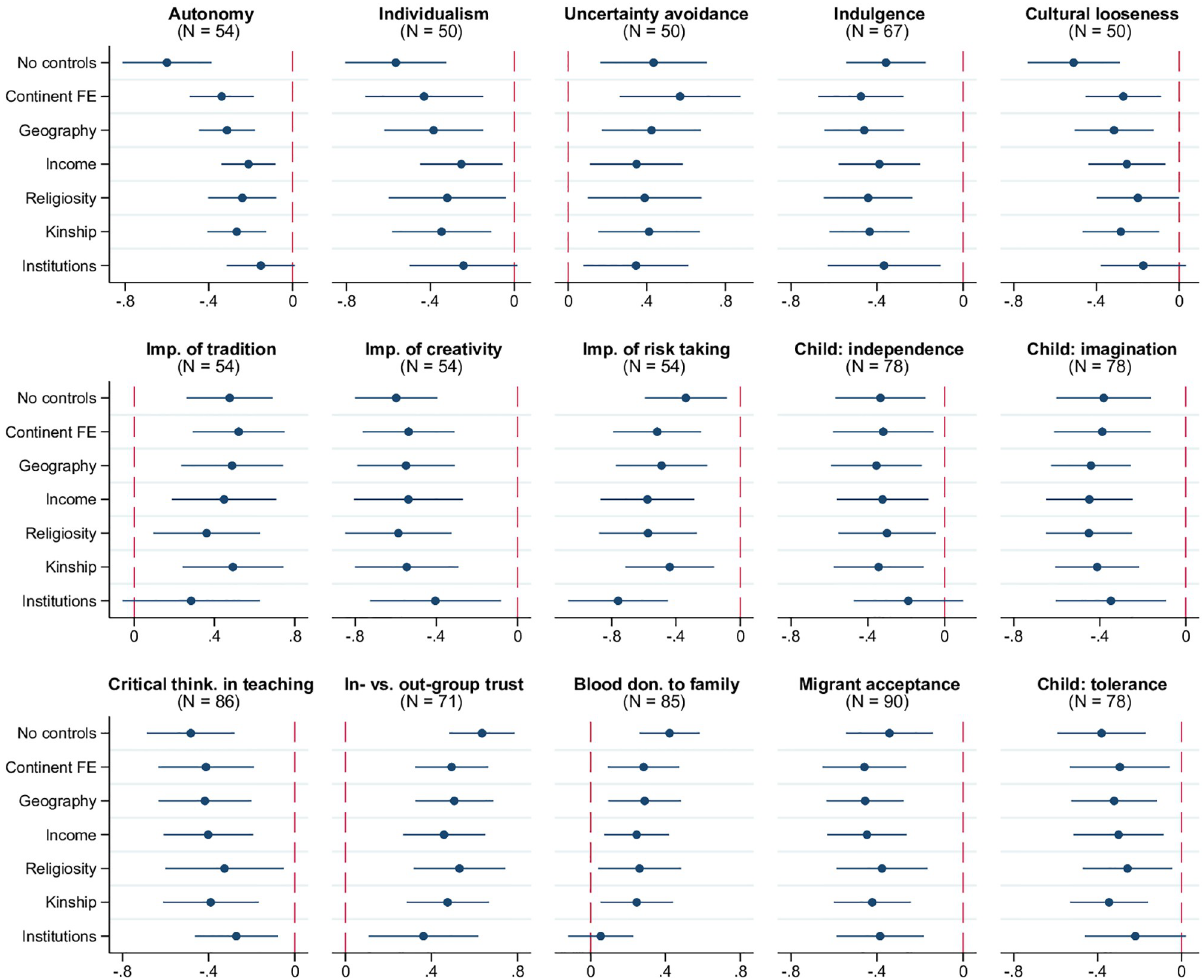
Fig 4. Witchcraft beliefs, conformity, and in-group bias. Each panel of the figure presents the results of estimating 7 different models, in which the metric of conformity indicated in the panel title is regressed on the prevalence of witchcraft beliefs, along with a set of control variables. The latter is defined as follows according to the tickmarks on the vertical axis: 1) none for “No controls”, 2) only continental fixed effects for “Continent FE”, 3) continental fixed effects and baseline geographic controls (absolute latitude, terrain ruggedness, agricultural suitability of land, distance to the coastline) for “Geography.” The remaining 4 models, named “Income,” “Religiosity,” “Kinship,” and “Institutions” include, respectively, real GDP per capita, average religiosity, kinship intensity index, and the rule-of-law index (in addition to continental fixed effects and geographic variables). The round marker represents the point estimate for the coefficient on the prevalence of witchcraft beliefs, and the linear segment around each marker is the respective 95% confidence interval based on heteroskedasticity-robust standard errors. Sample size N indicated in parentheses. The key variables are standardized to have zero mean and unit standard deviation in relevant